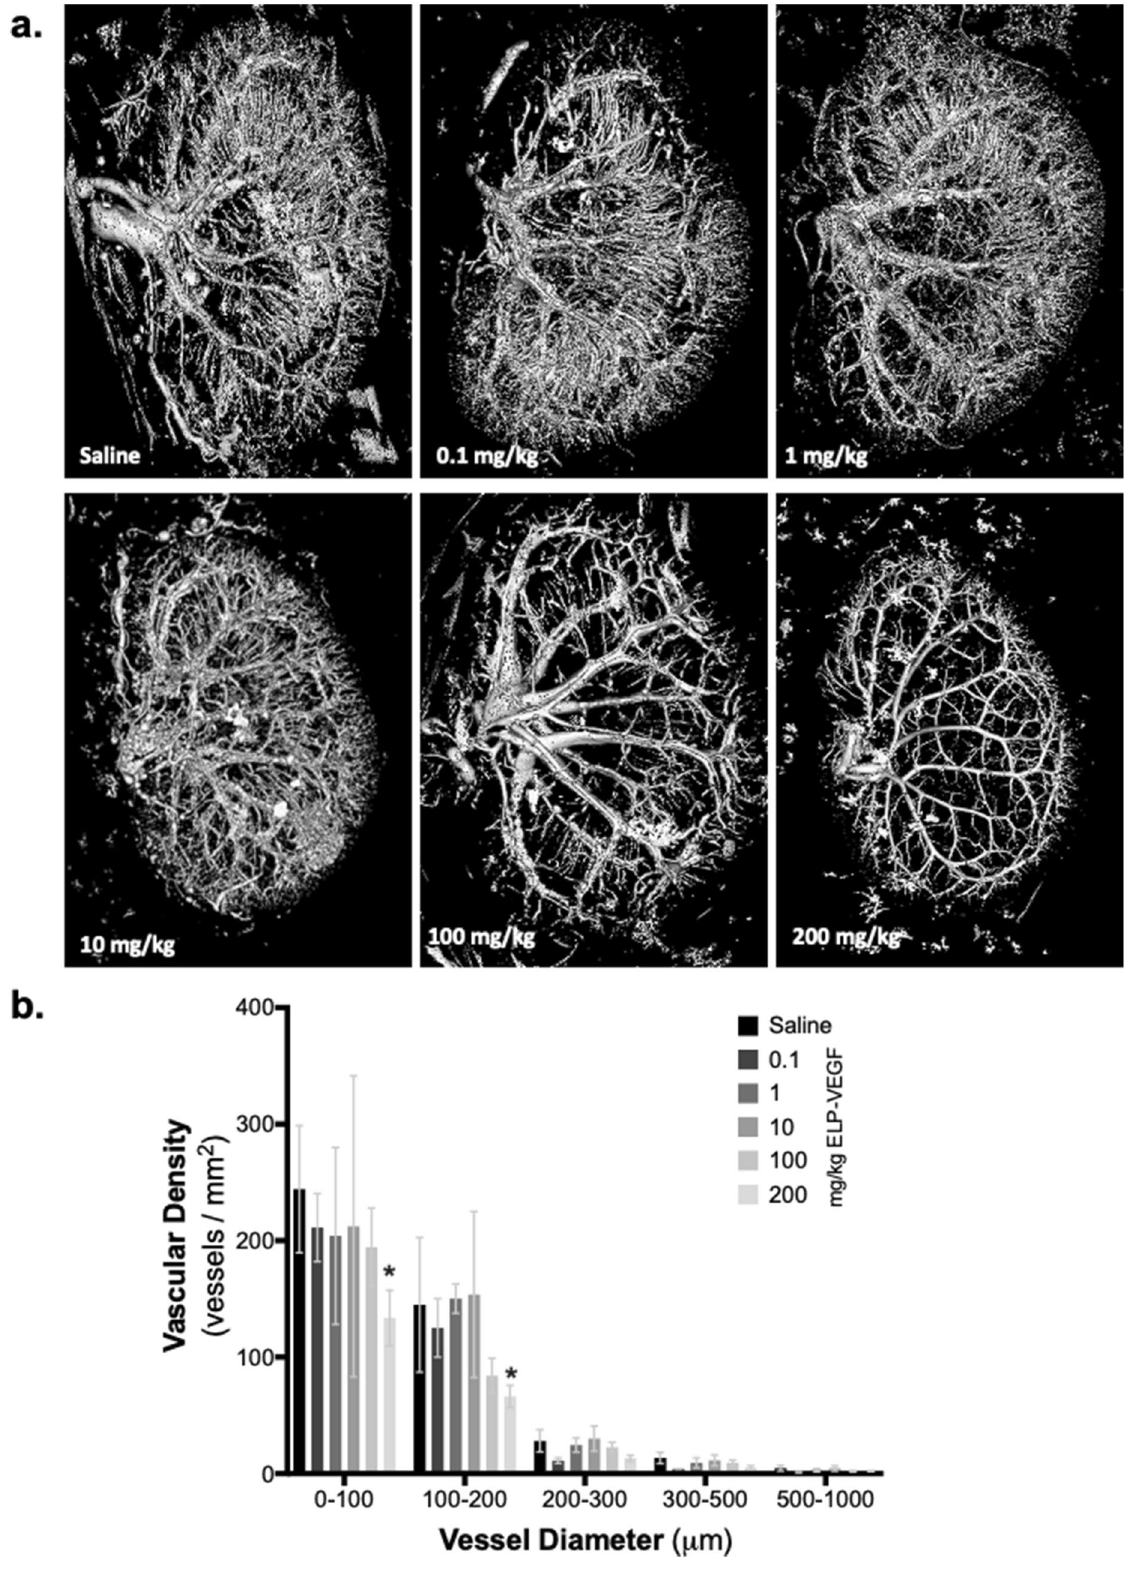
Figure 6. Renal Microvascular Density Following ELP-VEGF Therapy. (a) One kidney was perfused with Microfil on Day 14 following ELP-VEGF therapy, and microvascular density was assessed by μCT scanning. (b) Microvascular density of variously sized vessels was quantified from the reconstructed μCT images. * Statistically significant decrease relative to saline treated rats, p < 0.05, two-way ANOVA with post-hoc Dunnett correction for multiple